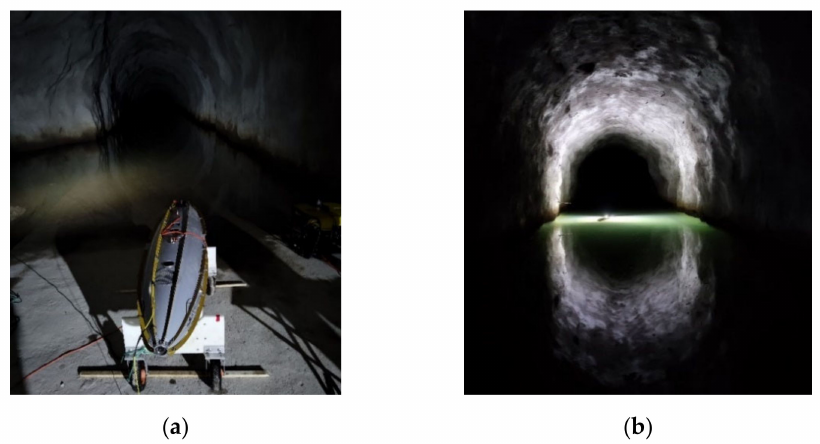
Figure 12. Experiment in Zhejiang, China.